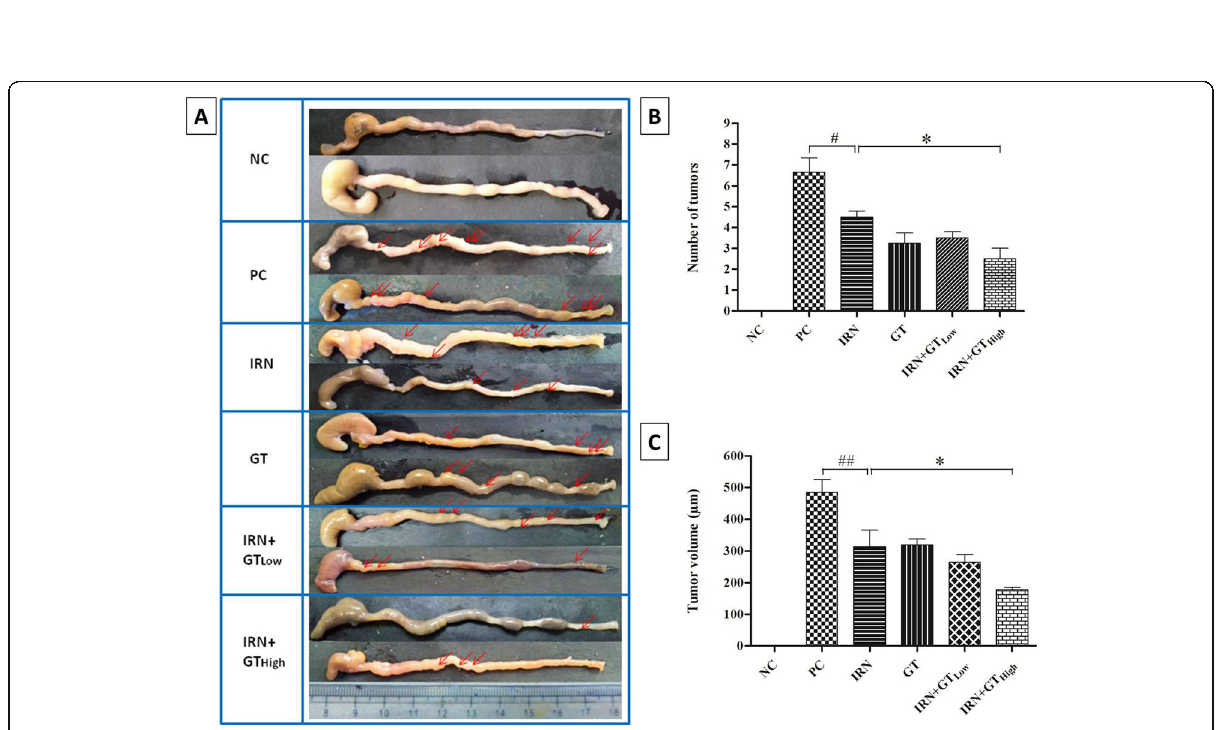
Fig. 4 Effect of IRN and GT on A , B tumor number and tumor volume ( C ) during the 12-week treatment period. Values were presented as mean ± SEM, # p < 0.05, ## p < 0.01, and ### p < 0.01 when compared to the PC group and * p < 0.05, ** p < 0.01, and *** p < 0.001 when compared to the IRN group. Tumor number was recorded to be less in the IRN+GT High group as compared to the IRN group. Significant decrease in tumor volume was recorded in the IRN+GT High group as compared to the IRN